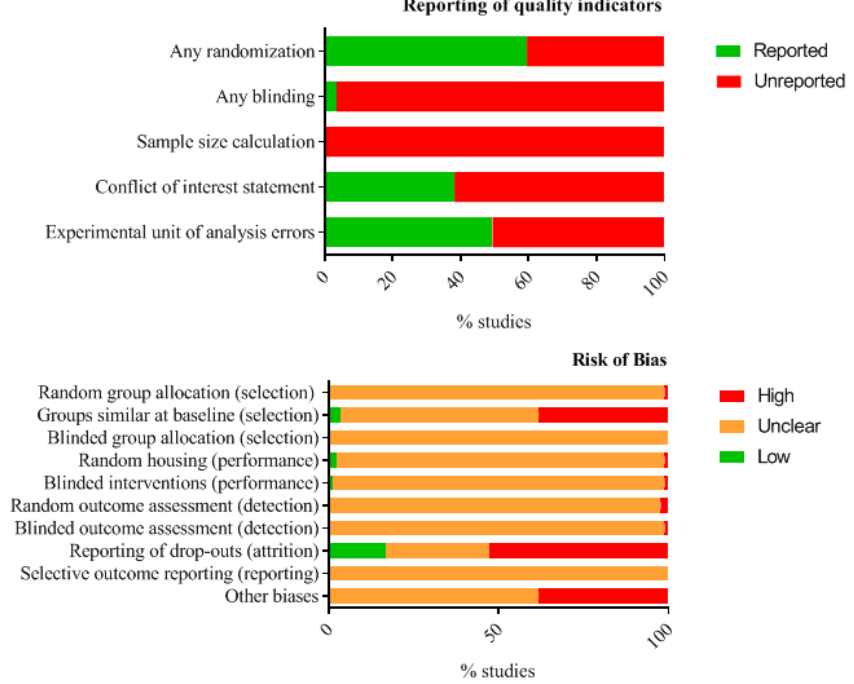
Figure A16. Reporting quality and risk of bias in animal studies. Reporting of key indicators of study quality and risk of bias in animal studies was assessed for all items, but especially blinding, randomization and sample size calculation scored as unreported, unclear or high risk.